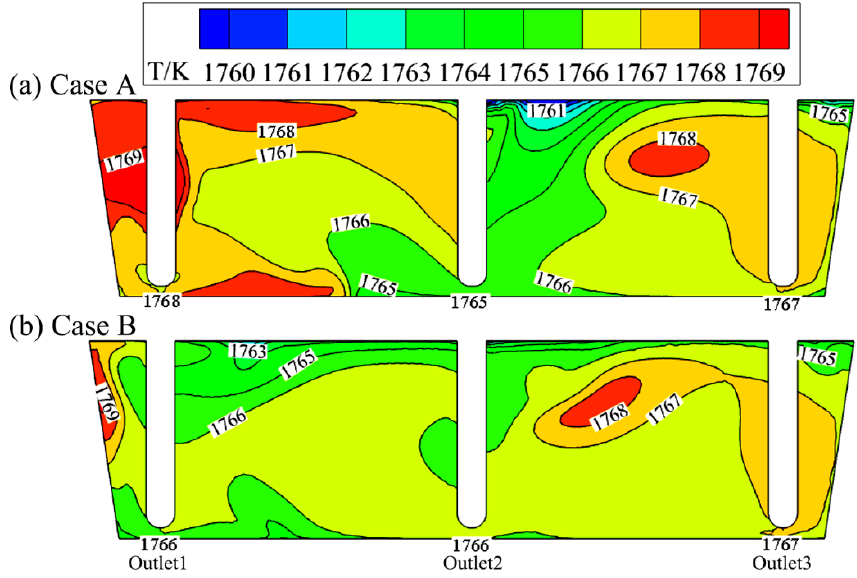
Figure 6. Comparison of temperature distribution of cases A ( a ) and B ( b ) in the vertical section of outlet center.